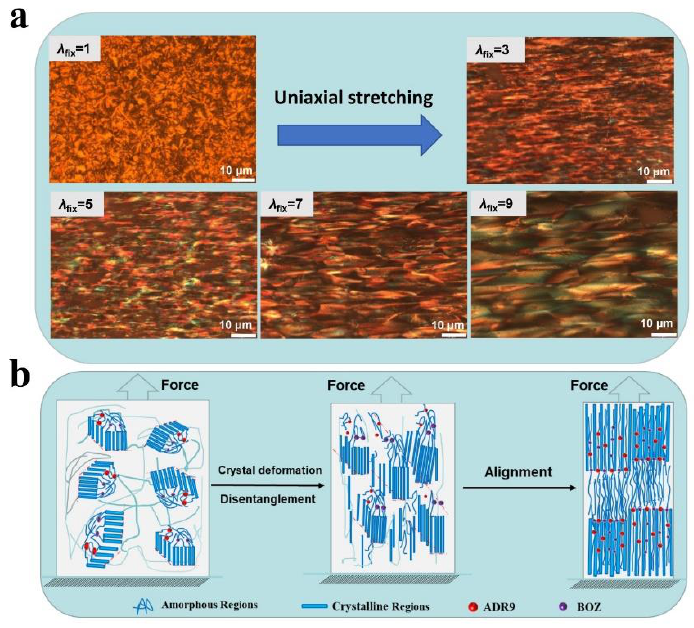
Figure 8. Polarizing microscope analysis of stretch oriented samples. Polarized light optical micro- graphs of the pre-stretched samples. ( a ) Micrograph of the sample surface taken in the pre-stretching state. The scale bar is 10 μm. All the samples were oriented with pre -stretch at 95 °C. ( b ) After uniaxial stretching, the crystal deformation and molecular chains are disentangled, and the molecular chains show anisotropy along the stretching direction.